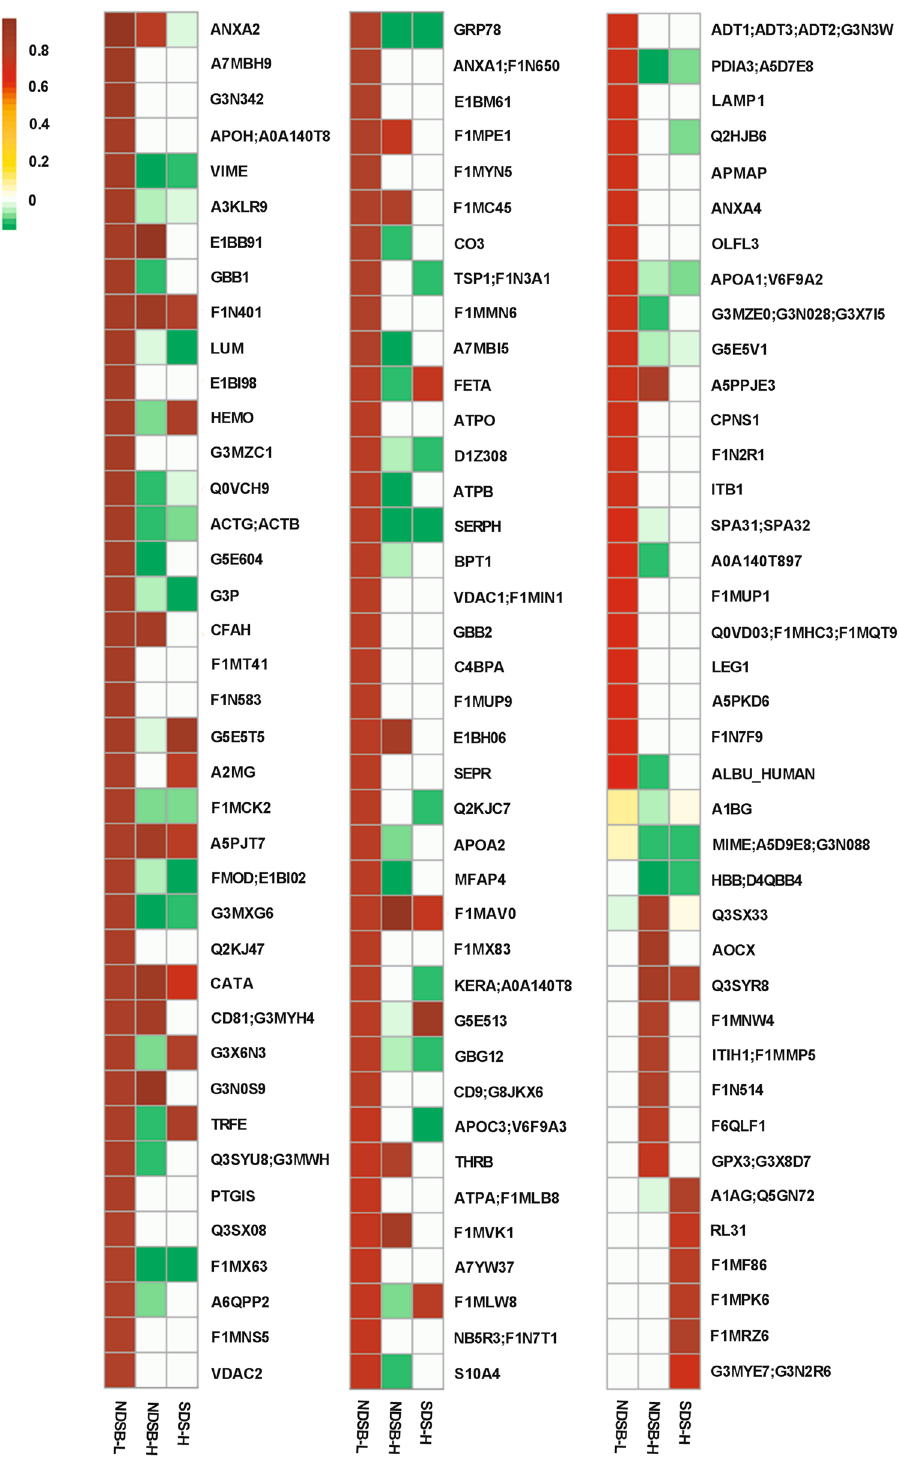
Figure 5. Heatmap of the statistically significant antigenic protein identifications within each extraction method. Antigens were predominantly identified in NDSB-L , but alternative extraction methods are required to optimize total number of antigens identified. Scale is a Log of the fold change. Proteomic data was analyzed using Guassian linearized modeling to determine the differential abundance of proteins between the groups as previously reported 60 . White squares indicate that the protein was not present in that sample. ( n = 6 per extraction method). Groups were considered significantly different when p <